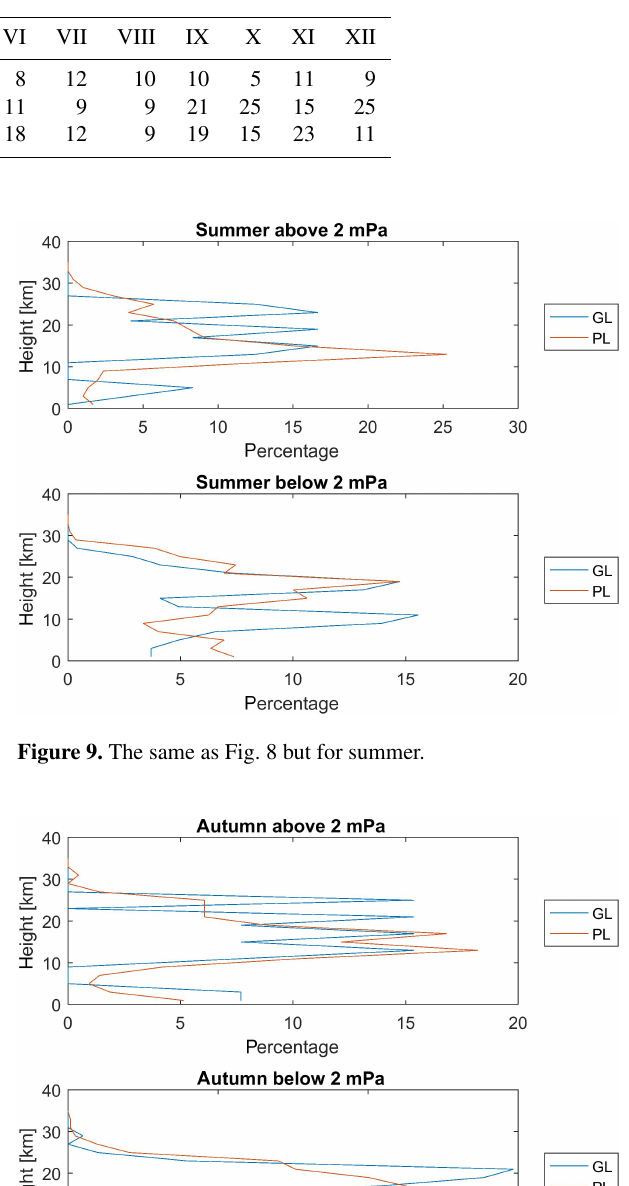
Table 4. Monthly values of the ratio of the number of PL and GL at the European midlatitudinal stations for laminae greater than 2mPa.